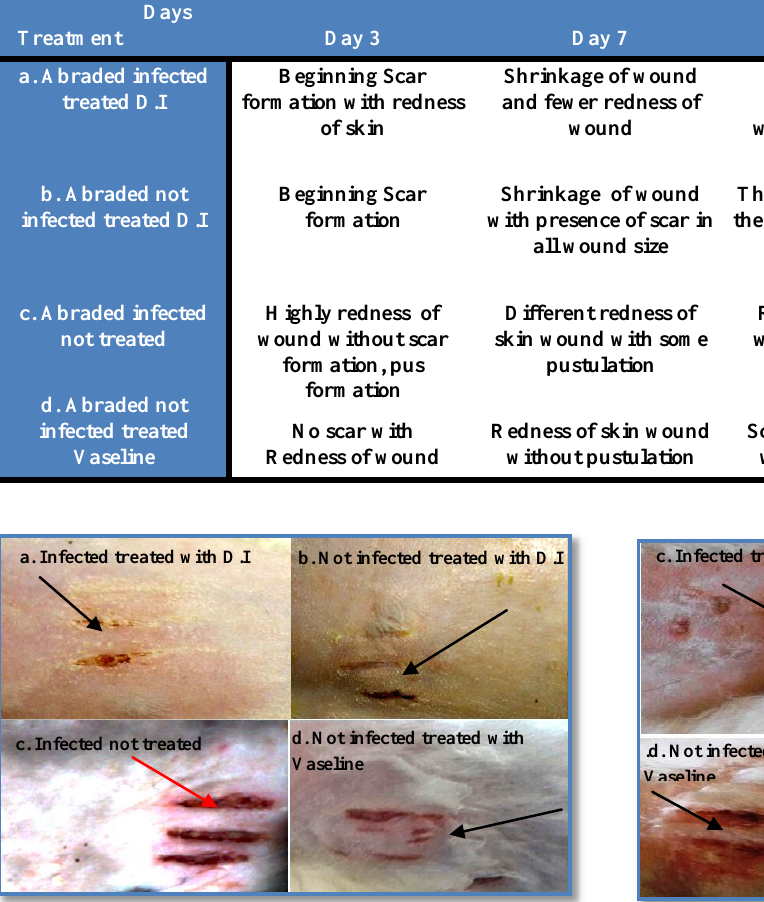
Figure, 1: Healing at day 14 treated with D.I extract ointment. Day 14 treated with D.I extract ointment at 3%. a. (Black arrow) nearly complete healing detached scar without signs of inflammation. b. (Black arrow) complete healing detached scar. c. (Red arrow) Redness with scar formation. d. (Black arrow) Scar formation without redness sings.